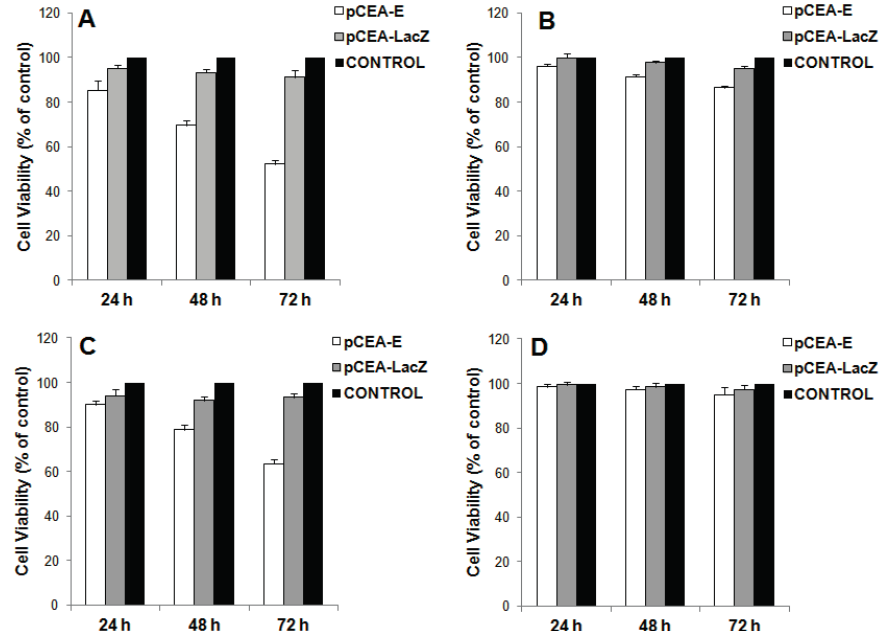
Figure 2. Effect of pCEA - E on cell proliferation. Cells from cell lines HTC-116 ( A ), T-84 ( B ), MC-38 ( C ) and CCD18co ( D ) were transfected with pCEA - E to determine proliferation rate modulation after 24, 48 and 72 h. Data represent the mean value of three replicates ± the standard error of the mean